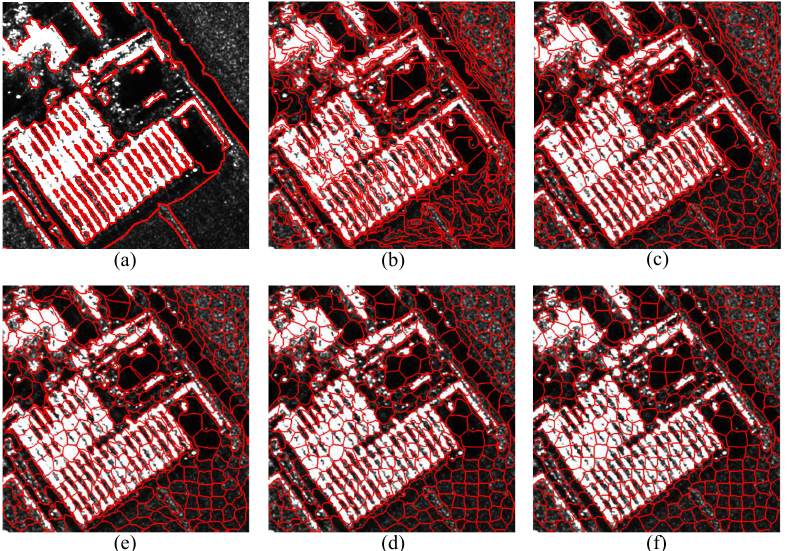
Figure 7. Superpixel generation results with different λ . ( a ) Ground truth. ( b ) λ = 0.2. ( c ) λ = 0.4.